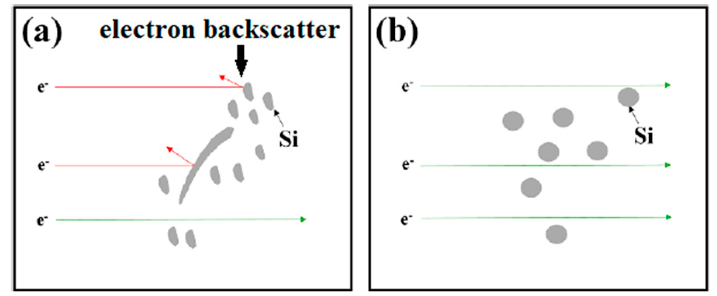
Figure 10. Electron movement in aluminum alloy: ( a ) as-cast; ( b ) heat treated.